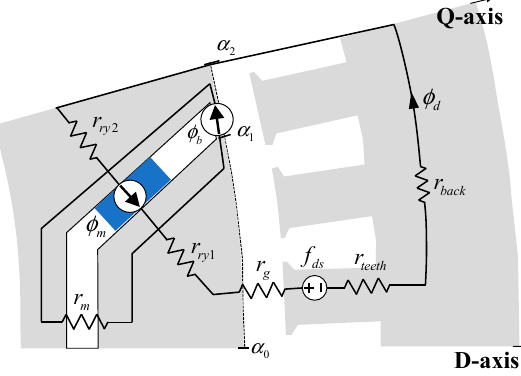
Figure 3. MEC for D-axis inductance.